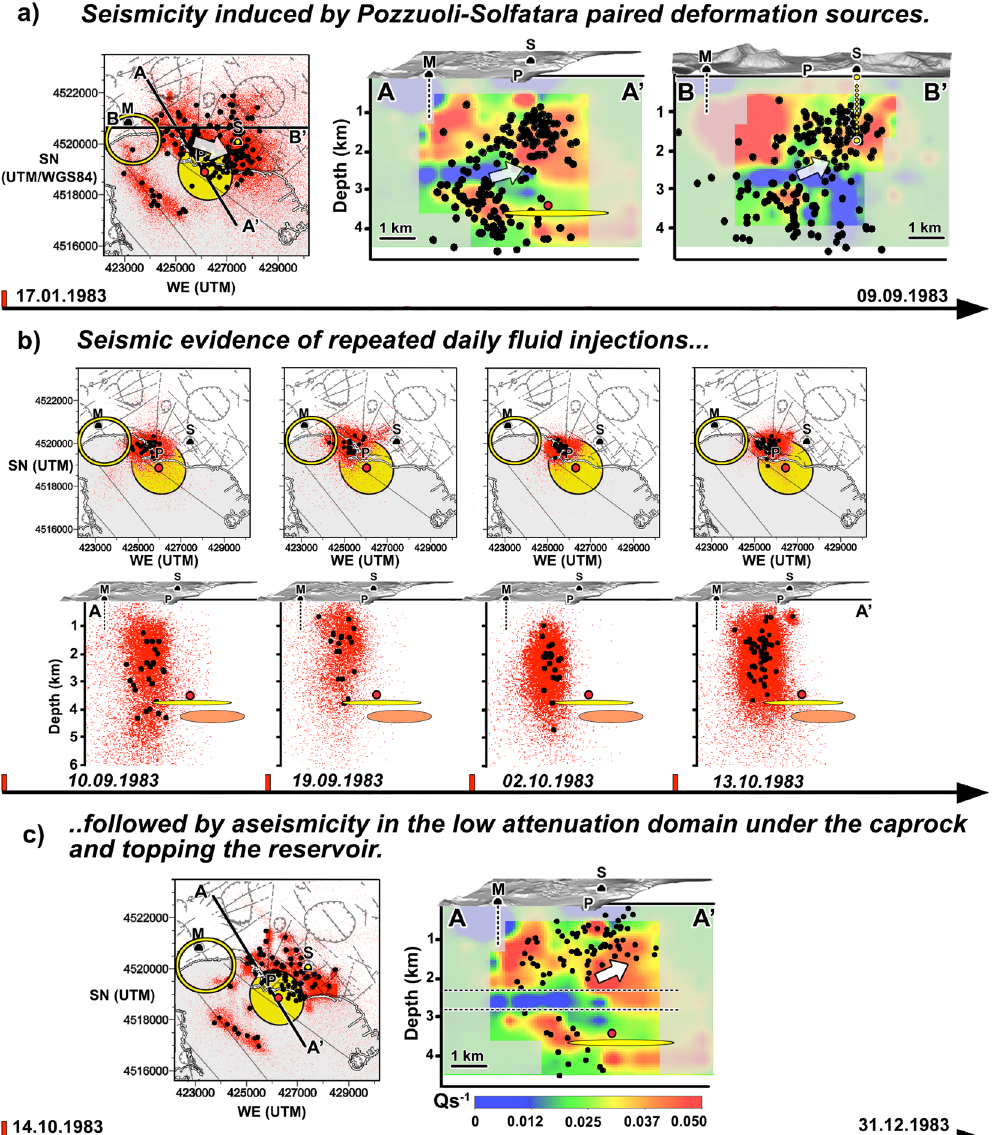
Figure 4. Time-dependent seismicity during the 1983 unrest. Microearthquakes (black circles) and corresponding probability density functions (PDF, red dots, 1000 samples per event) are drawn under the structural map of Campi Flegrei caldera (grey lines on each map) and on two vertical planes crossing the S-wave attenuation model (AA’ and BB’). All UTM coordinates use the WGS84 geodetic datum. The yellow circumference intersecting Mount Nuovo corresponds approximately to the end of the path followed by magma transfer and preceding the last eruption of the volcano 4 . All panels show the correlation of seismic and attenuation patterns with deformation sources. The sections of the main deformation ellipsoid (yellow ellipses) and magmatic anomaly (red circle) are shown on all maps and AA’ cross-sections. The small yellow circle on the maps and the BB’ cross-sections under Solfatara is the paired secondary deformation source 11 active under Solfatara. Panel (a): The white arrow outlines the seismic propagation from Pozzuoli to Solfatara inside the caprock before September-October 1983. Panel (b) shows the seismic signature of the fluid injections modelled by Chiodini et al . 17 using geochemical data. The 4–4.5 deep attenuation anomaly is approximated by an orange ellipse on all vertical sections. On a map, the resolved high-attenuation anomaly is concealed by the deformation anomaly. The figures were created using the same softwares and data described in Fig. 3 (ESRI ArcGIS 10.0 © , https://www.esri.com/training/catalog/5763042b851d31e02a43ed4d/using-arcmap-in- arcgis-desktop-10/; Voxler 3.0 © , http://www.goldensoftware.com/products/voxler; Photoshop CS © , https:// helpx.adobe.com/uk/x-productkb/policy-pricing/cs6-product-downloads.html. The PDF are created using SeismicityViewer (http://alomax.free.fr/nlloc/) and imposing the results on each